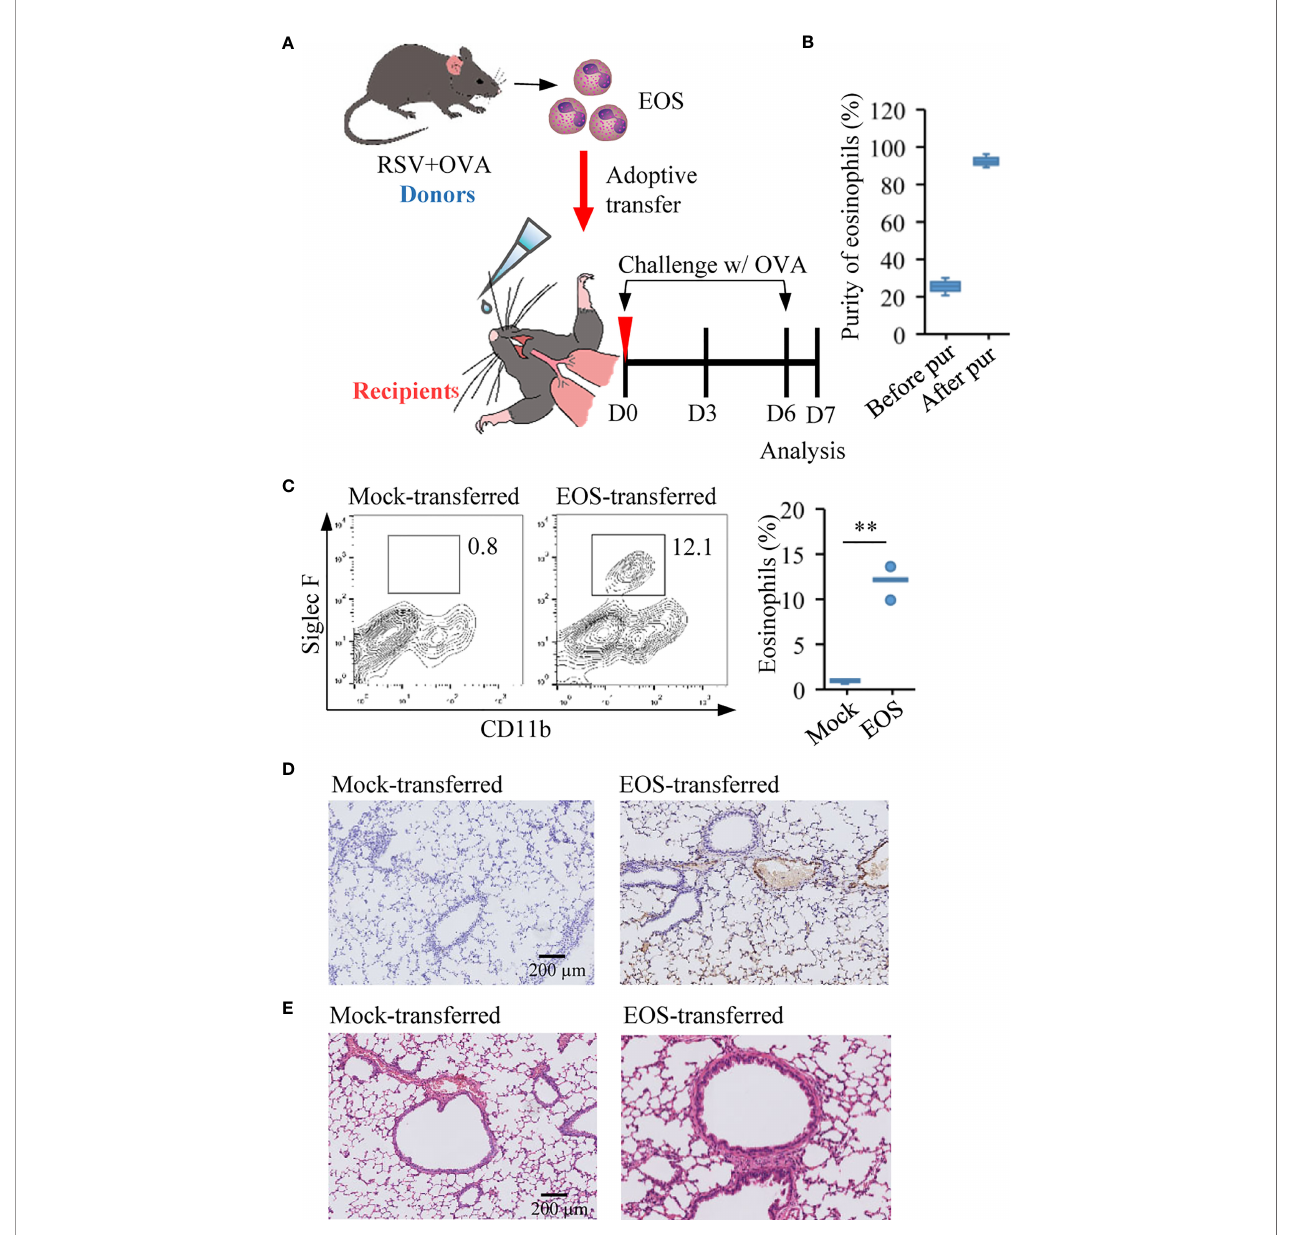
FIGURE 3 | Adoptive transfer of asthmatic eosinophils leads to pulmonary damage. (A) Experimental design of adoptive transfer of eosinophils from RSV+OVA mice to recipient mice. The mock-transferred mice were instilled into the nasal with vehicle control (normal saline/20 µl) and the EOS-transferred mice were instilled with highly puri fi ed eosinophils (1 × 10 7 cells/20 µl) from RSV+OVA mice. After adoptive transfer, the two groups of mice were directly challenged with OVA aerosol inhalation to give a foreign antigen stimulation. (B) The purity of eosinophils was evaluated by visual examination of Diff-Quick-stained cytospin preparations. (C) The presence of eosinophils after adoptive transfer was validated by fl ow cytometry. Quanti fi cation of eosinophil are presented as box plots ( n = 5), ** p < 0.01. (D) Immunohistochemical detection of eosinophils in lung tissue sections was performed by detected MBP protein. The scale bar is 200 m m. (E) Images show representative H&E-stained sections from lung of mock-transferred and EOS-transferred mice. The scale bar is 200 m